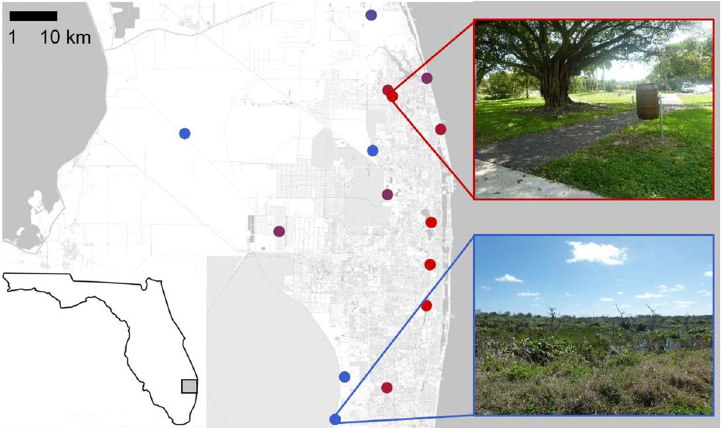
Fig 1. Map of 15 sampling sites on the eastern coast of South Florida where American white ibises were captured to collect fecal specimens to determine their gastrointestinal microbiome. Sampling sites represented a gradient of urban land cover from 0% (blue) to 91% (red; see also S1 Table). Inset circles demonstrate the range of difference in urban habitat across the urban land cover gradient, ranging from open wetland (blue inset) to densely inhabited residential areas (red inset). Basemap © OpenStreetMap contributors,